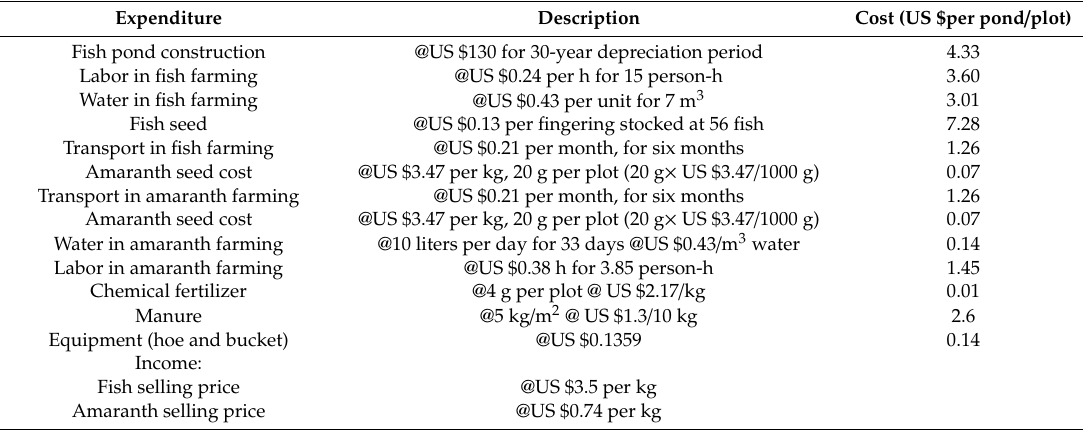
Table 7. Input information used for the partial enterprise budget